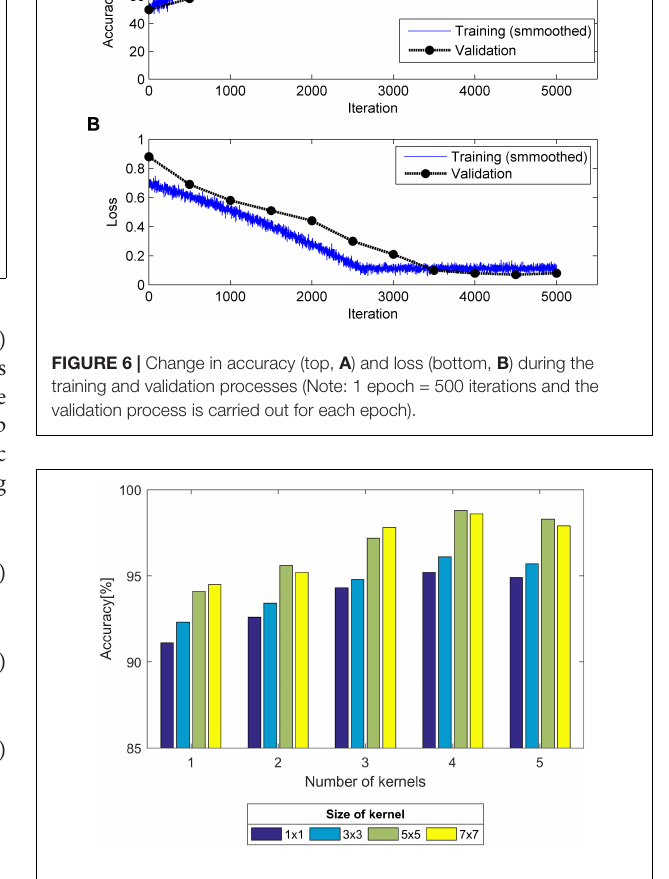
FIGURE 7 | Comparison of the validation accuracy with the size and number of